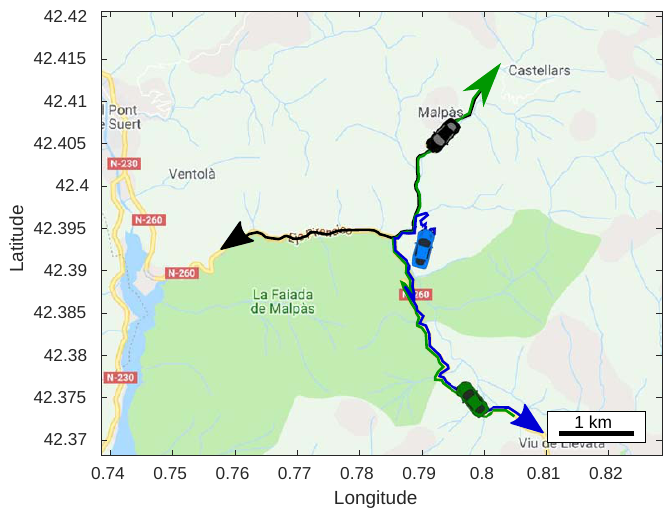
Figure 4. Trajectories for ground vehicles in our experiments.